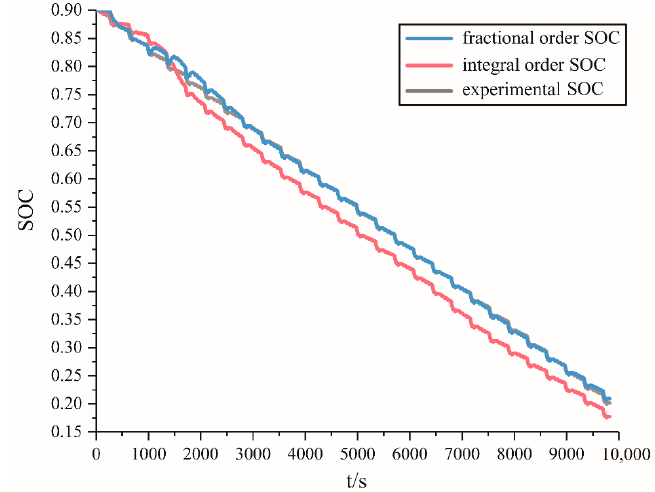
Figure 17. Comparison of SOC filtered by FEKF and EKF under 26 continuous DST conditions at 28 ◦ °C.